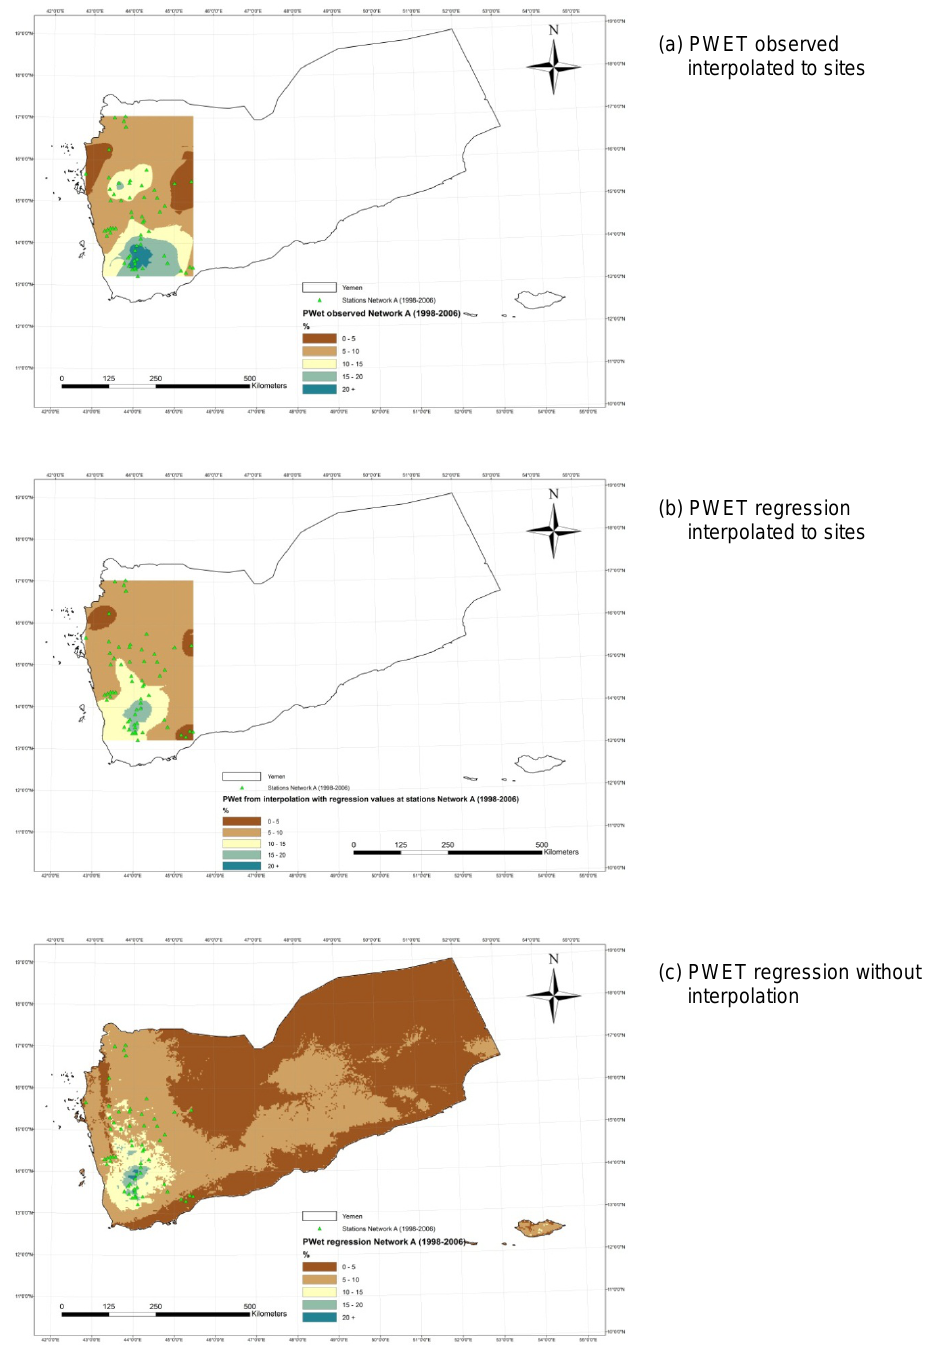
Fig. 9. Observed and modelled wet-day probabilities (PWET) based on Network